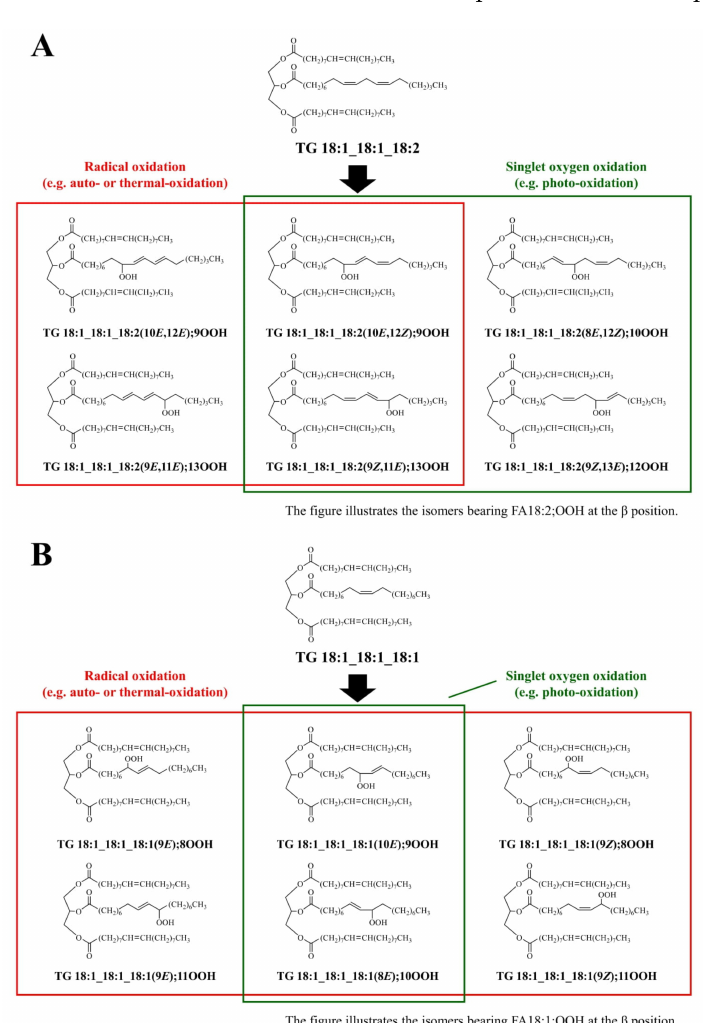
Figure 1. Triacylglycerol (TG) oxidation mechanisms and chemical structures of TG 18:1_18:1_18: 2;OOH isomers ( A ) and TG 18:1_18:1_18:1;OOH isomers ( B ). Isomeric structure of TGOOH depends on oxidation mechanisms (radical and 1 O 2 oxidation). The shorthand notation of lipids was in accordance with LIPID MAPS